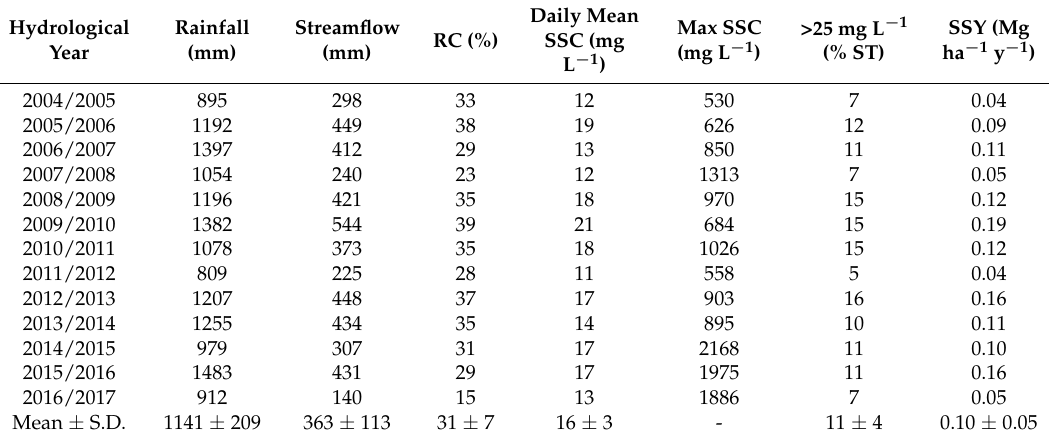
Table 1. Annual rainfall, streamflow and suspended sediment.